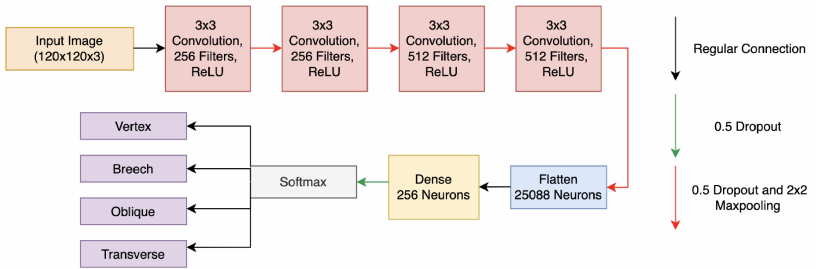
Figure 2. Complete Fet-Net architecture and classification of a fetal